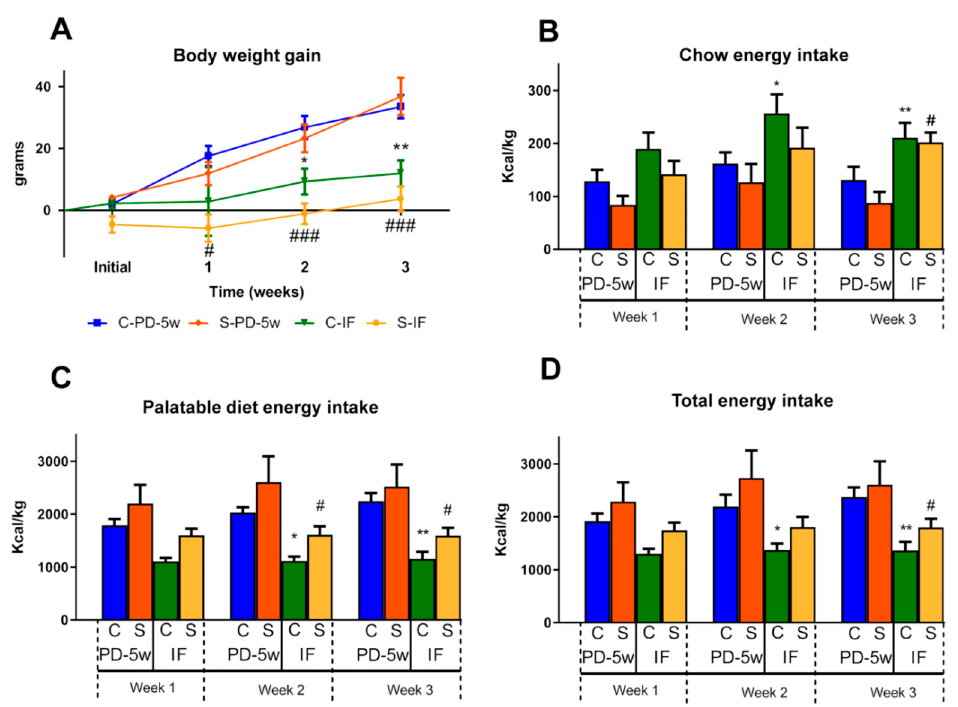
Figure 4. Effect of stress and intermittent fasting on rats fed with a palatable diet. ( A ) Body weight gain of the control or stressed animals fed with a PD and subjected to two feeding schedules: food available all day (with a cumulative intake time of 5 weeks, C-PD-5w, S-PD-5w) or intermittent fasting (C-IF, S-IF) for 3 additional weeks. Data are represented as the mean ± SEM of grams of b.w. (n = 8 rats/group); ( B ) Chow energy intake; ( C ) Palatable diet energy intake; and ( D ) Total energy intake (Kcal/Kg b.w; n = 4 cages/group. Data represent the mean ± SEM. * p < 0.05, ** p < 0.01 vs. C-PD-5w; # p < 0.05, ### p < 0.001 vs. S-PD-5w.